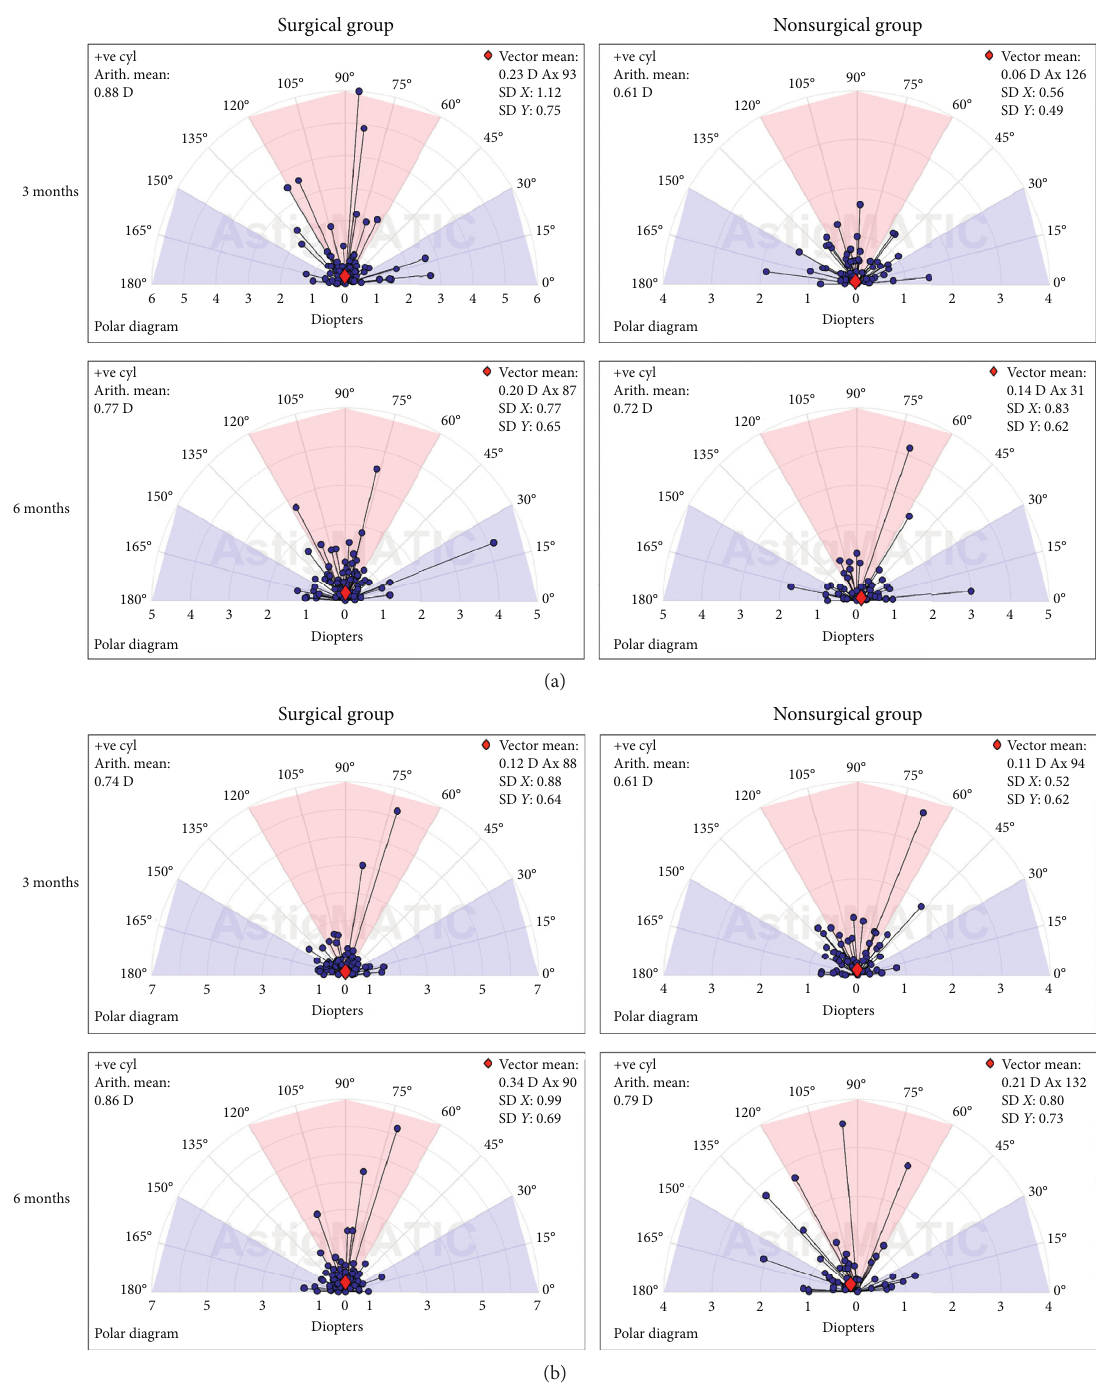
Figure 2: Single-angle polar plots of treatment-induced astigmatism (TIA) vector, including refractive (a) and keratometric (b) astigmatism at postoperative 3 and 6 months using Alpins’